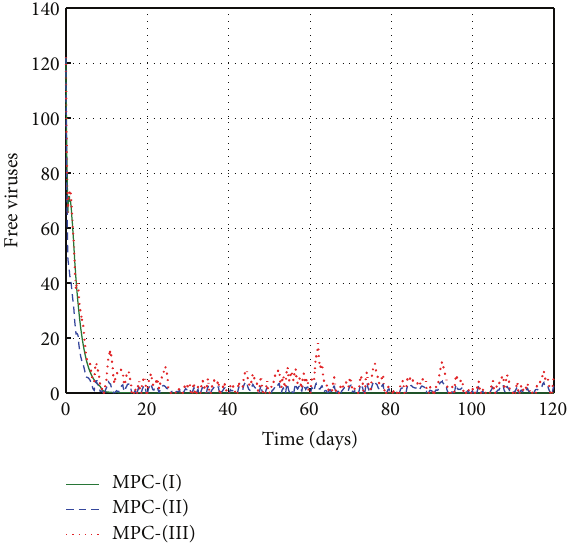
Figure 3: The evolution of free virus for untreated case.